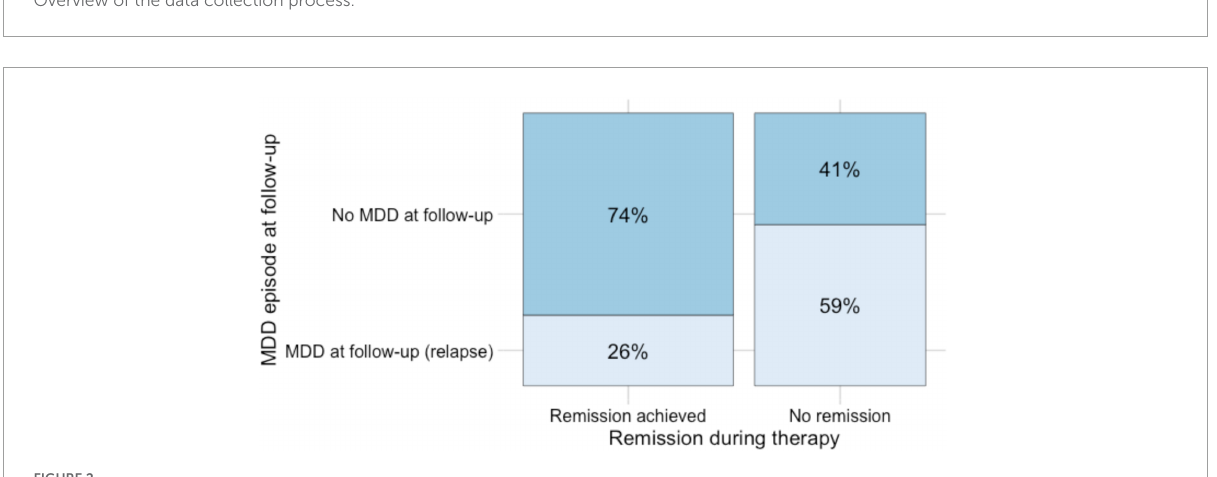
FIGURE1 Overview of the data collection process.